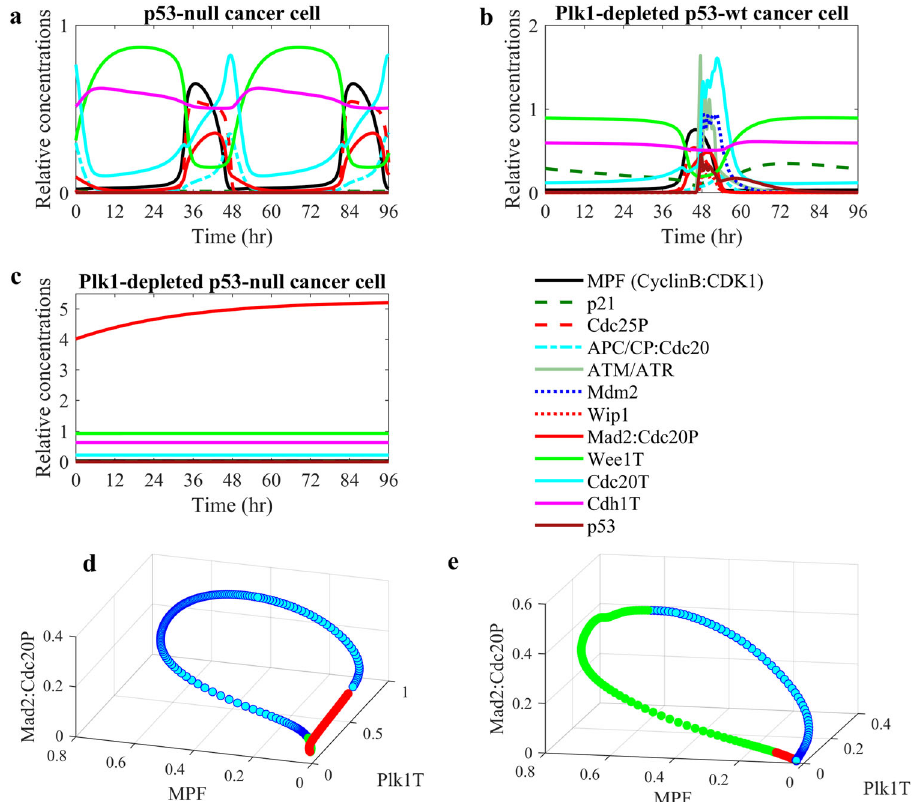
Fig. 3 Numerical simulations of Plk1 depletion in p53-wild-type and p53-null cancer cells. a Dynamic behavior of model components in p53-null cancer cells. b Plk1-depleted p53-wt cancer cells. c Plk1-depleted p53-null cancer cells. The phase plots ( d ) and ( e ) show the limit cycles that correspond to simulations of p53-null and Plk1-depleted cells in ( a ) and ( b ). The limit cycle oscillations are directed counterclockwise from red to green. In the Plk1-depletion condition, Plk1 level was reduced by 70% relative to Plk1 level in cancer cells under normal